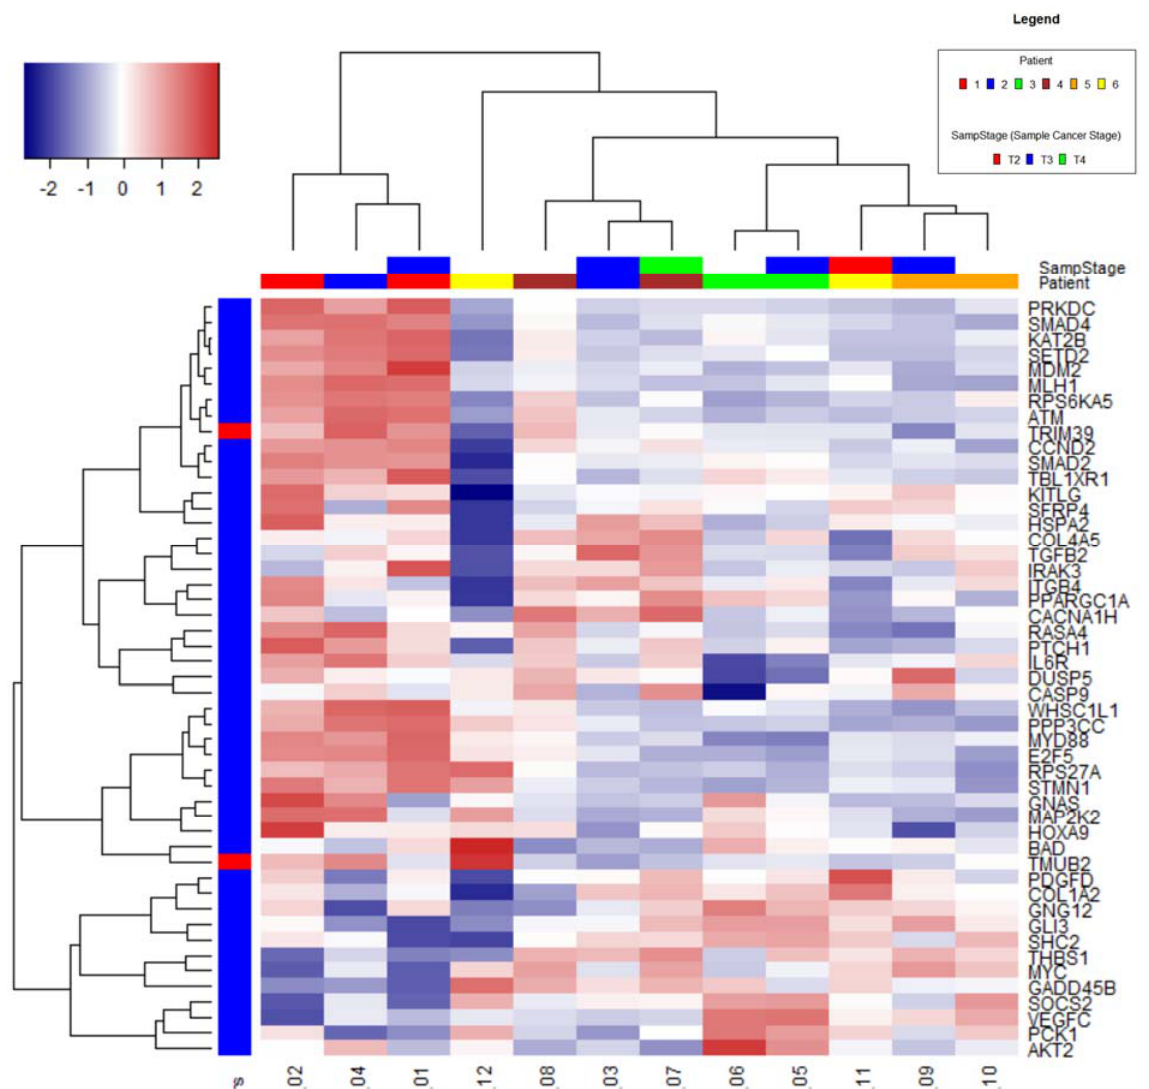
Figure 1. Hierarchical clustering for the 50 genes with highest variance. The heat map diagram shows the result of the two-way hierarchical clustering of genes and samples. Each row represents one gene and each column represents one sample. The gene clustering tree is shown on the left. The colour scale shown at the top-left illustrates the relative expression level of genes across all samples: blue colour represents an expression level below mean, red colour represents expression higher than the